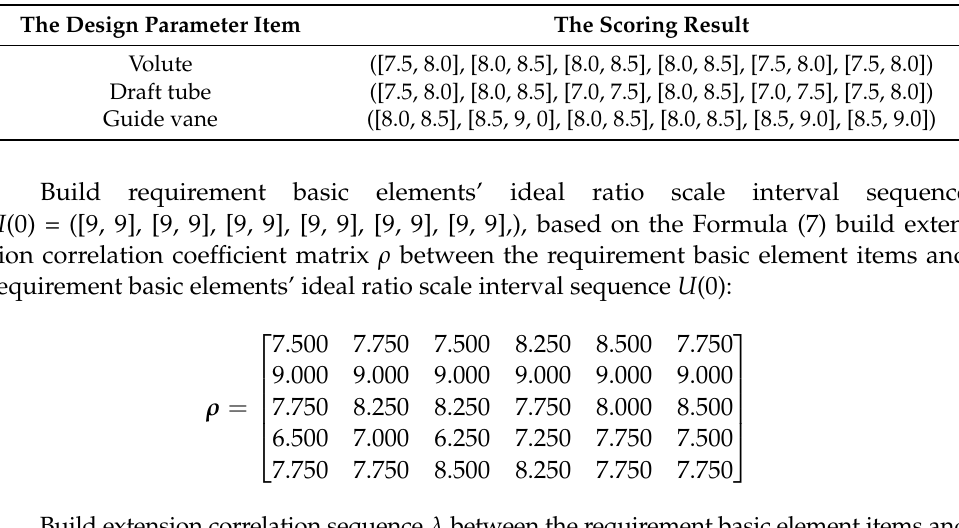
Table 5. The Scoring Results of Design Parameter